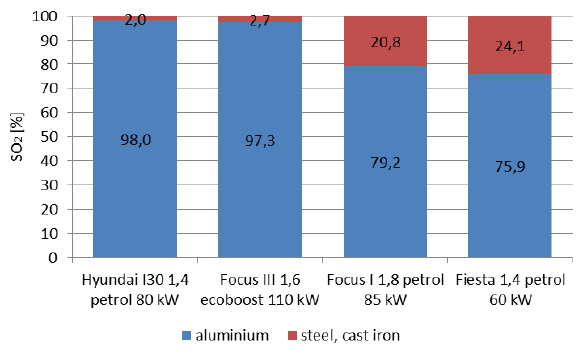
Fig. 4. Percentages of SO 2